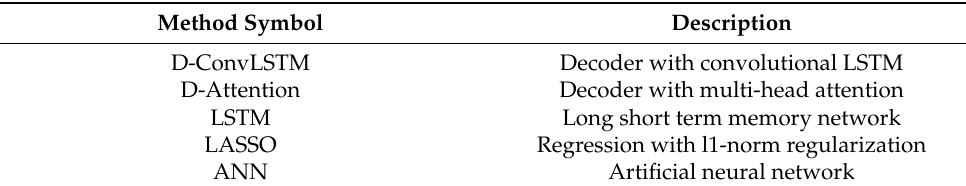
Table 5. Symbols and descriptions of the proposed method and other methods for traffic flow predictions.